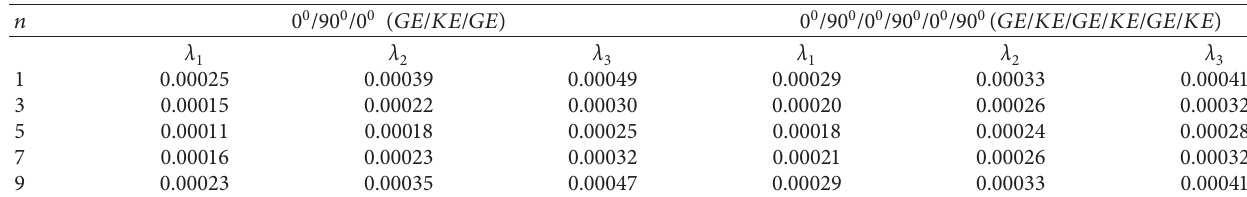
Table 3: Relation between frequency λ n